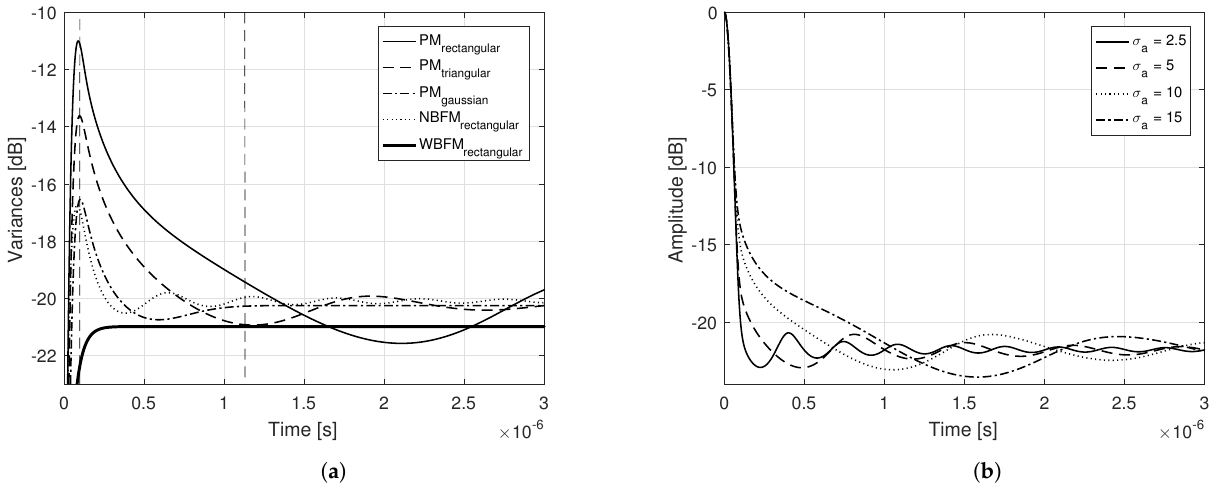
Figure 5. ( a ) Variance of the matched filter output power relative to different transmit signals obtained varying the modulating signal’s properties and the modulation procedure and ( b ) expected value of the matched filter output power of different transmit signals obtained varying the modulating signal’s random samples standard deviation and bandwidth, considering a rectangular power spectral density and phase